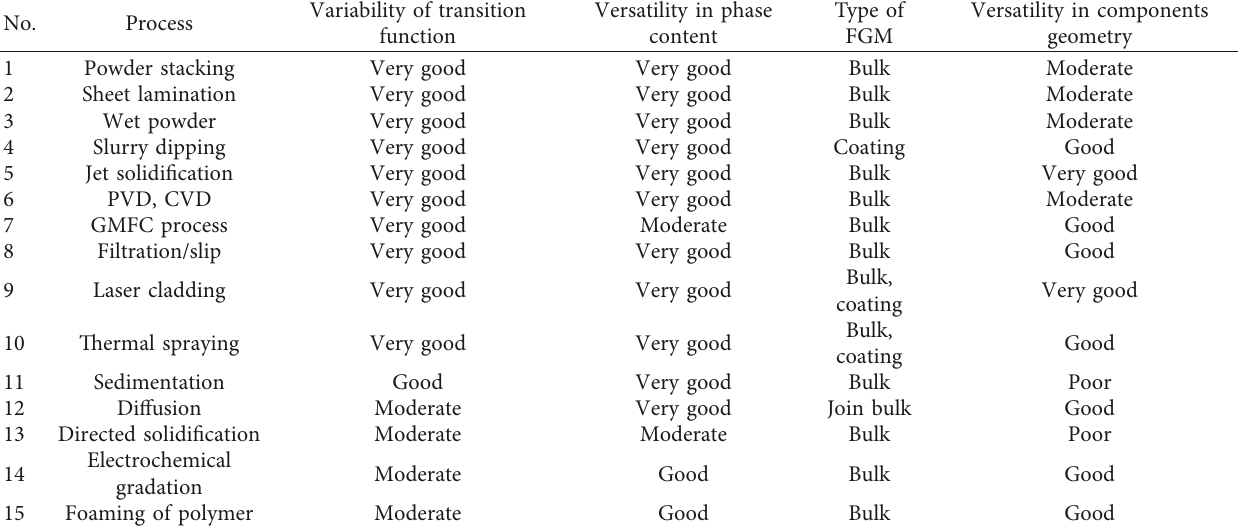
Table 2: Comparison of different processing processes of FGM [19,